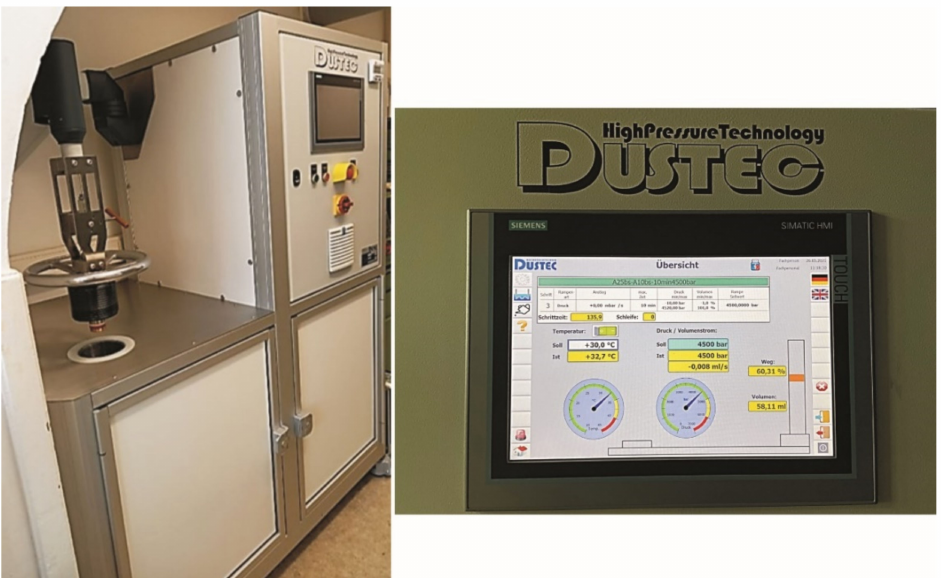
Figure 5. Pressure testing system (HighPressureTechnology Dustec, Wismar, Germany), with a sample volume of 200 mL. High hydrostatic pressures up to 600 MPa can be applied. Temperatures between 0 ◦ C and 40 ◦ C can be set constantly during HHP